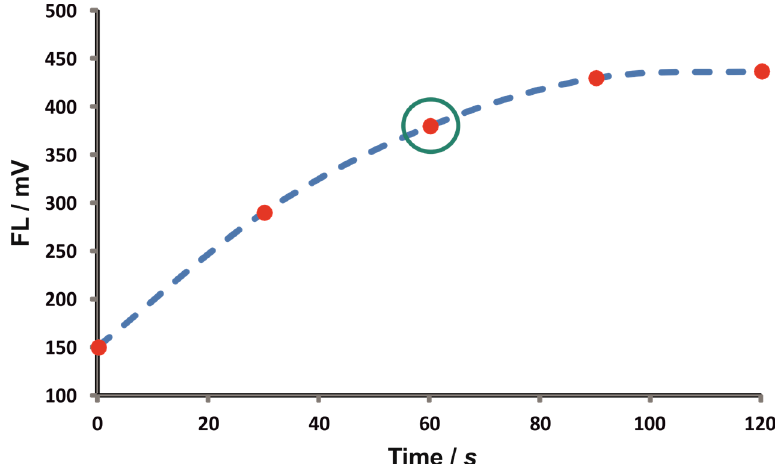
Figure 2. Effect of the reaction time under stopped-flow conditions; t = 0 corresponds to the delivery of the reaction product to the detector through the reaction coil without the stopped-flow step.